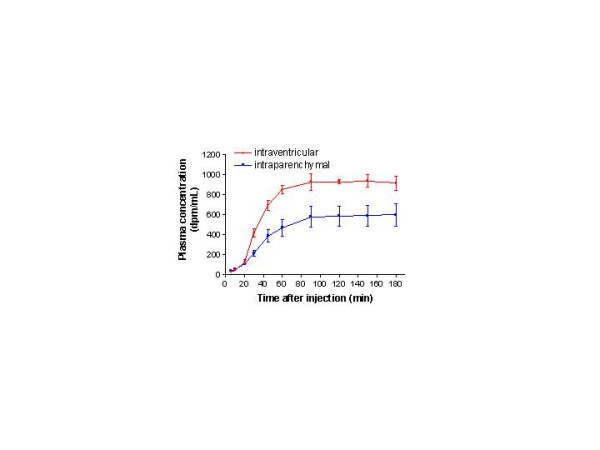
Plasma radioactivity over time after infusions into the lateral ventricle and parenchyma. Data are shown as mean ± SD. Plasma concentrations were fairly similar for both infusions up to 20 min, when the intraventricular infusion began to yield higher radioactivity; plasma concentrations for intraventricular infusions were about 50% higher than those for intraparenchymal infusion at 90–180 min. These data plus those in Fig. 2 clearly show the much greater clearance of intraventricularly infused 125I-IGF-1.